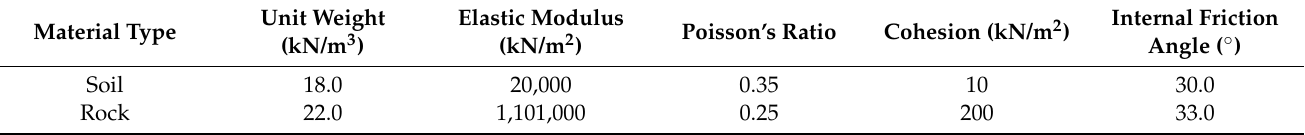
Table 2. Joint parameters for this study